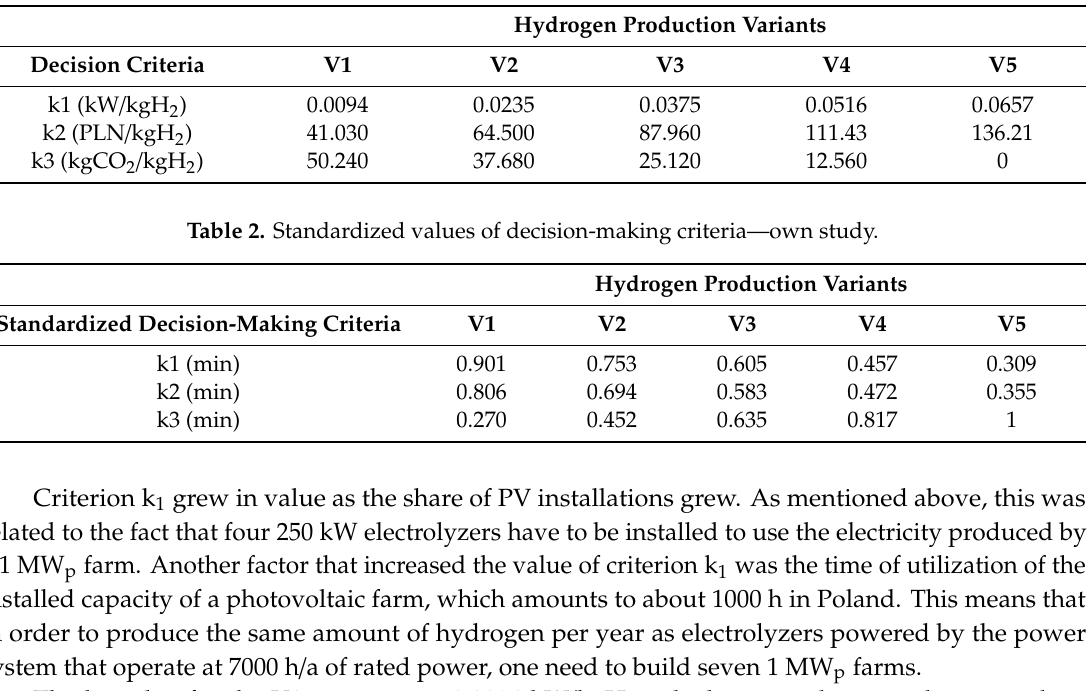
Table 1. Values of decision criteria—own study.